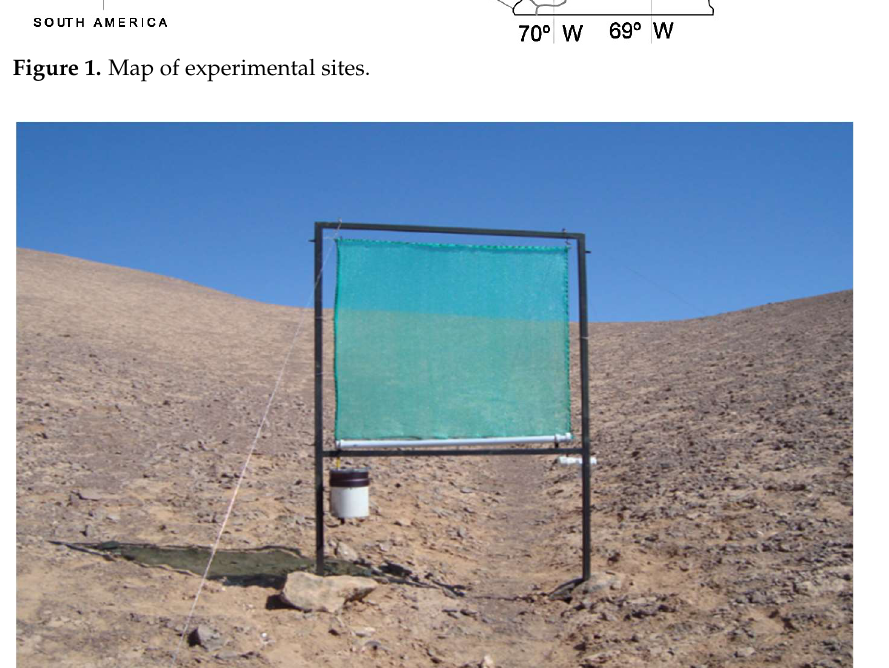
Figure 2. Fog water collector positioned nearby the P3 site. A 1 × 1 m 2 polypropylene Raschel mesh was mounted in a metal frame structure. It was equipped with a T / RH Hobo logger sensor (bottom right side) and a Hobo Onset logging rain gauge model RG2-M (bottom left side).